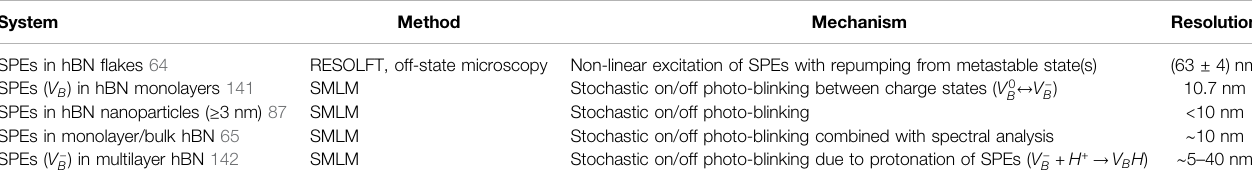
TABLE 1 | Super-resolution imaging techniques based on hBN emitters. System Method Mechanism SPEs in hBN fl akes